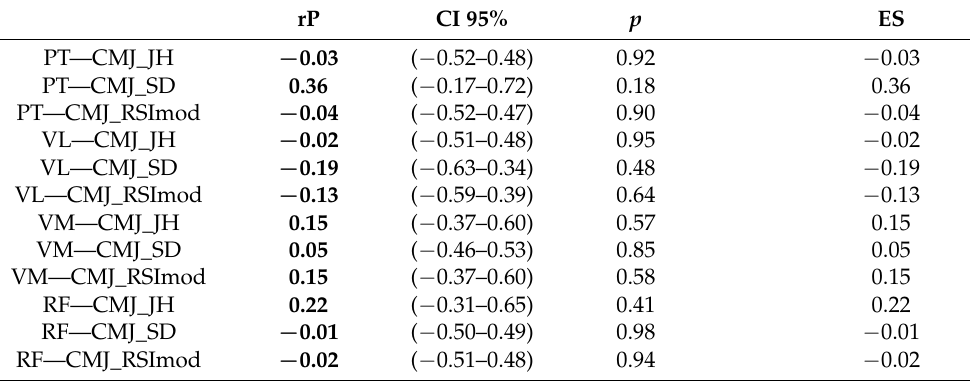
Table 3. Pearson’s correlation (=rP) between countermovement jump (CMJ) performance values (JH—jump height; SD—squat depth; RSImod—reactive strength index modified) and the stiffness of the patellar tendon (PT), vastus lateralis (VL), vastus medialis (VM), and rectus femoris (RF). The correlation is in bold; CI—confidence interval; ES—effect